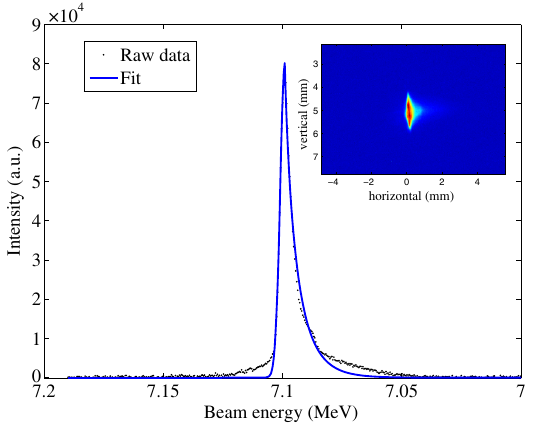
FIG. 16. Example of a non-Gaussian horizontal beam profile in the spectrometer at 7.1 MeV (black points), with a modified super-Gaussian function fitted to the data (blue line). The inset shows the original screen image.